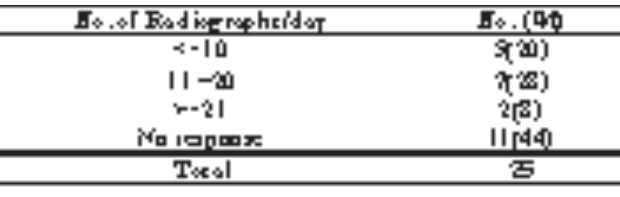
Table III : No of Radiographs seen/day by a